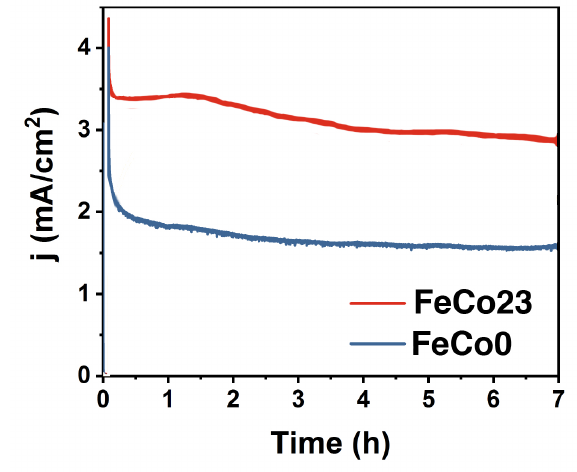
Figure 4. Comparative chronoamperometry with FeCo23 or FeCo0 electrodes. Electrolyte: 0.1 M KPi + 1 M KNO 3 , pH =